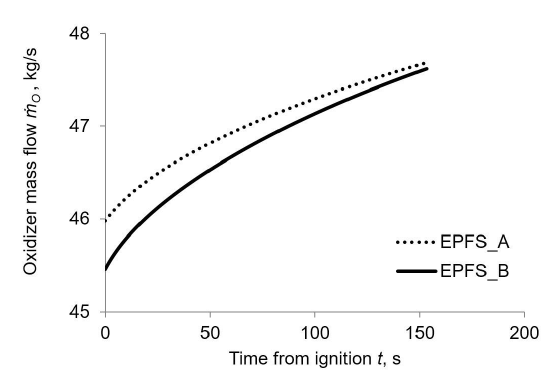
Figure 5. Discharge pressure history.